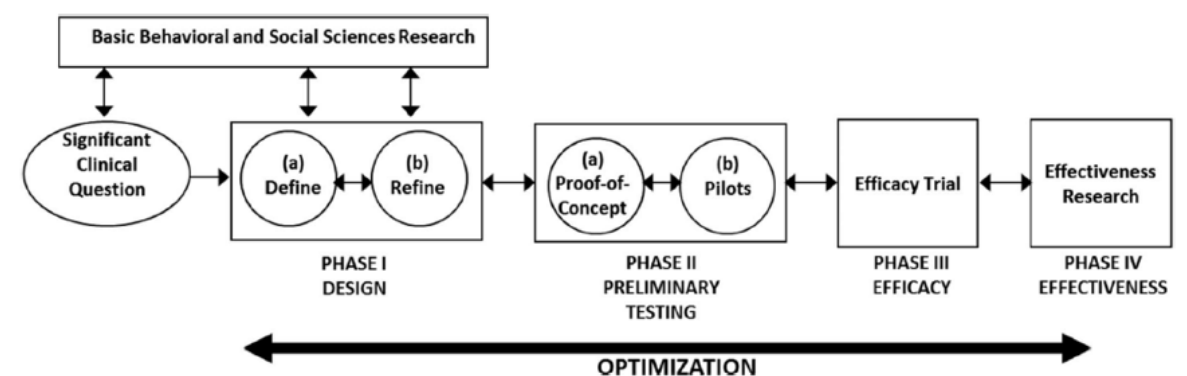
Figure 1. Obesity-Related Behavioral Intervention Trial